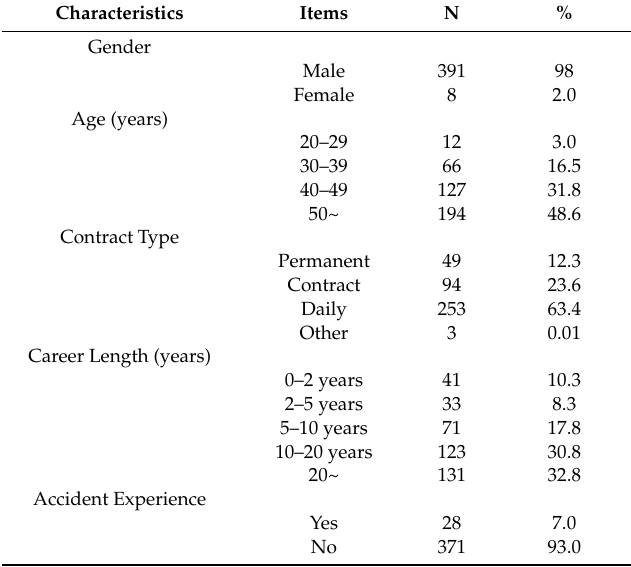
Table 4. Characteristics of samples in completed responses.